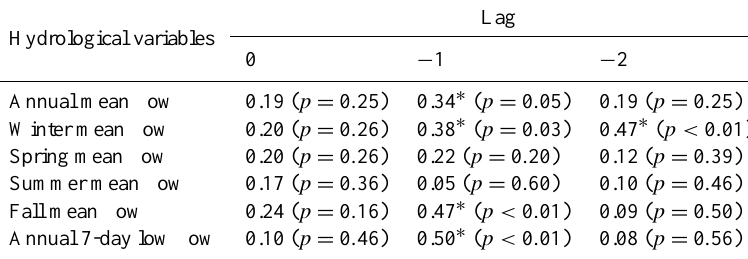
Table 2. Cross-correlation between hydrological variables and ECA.